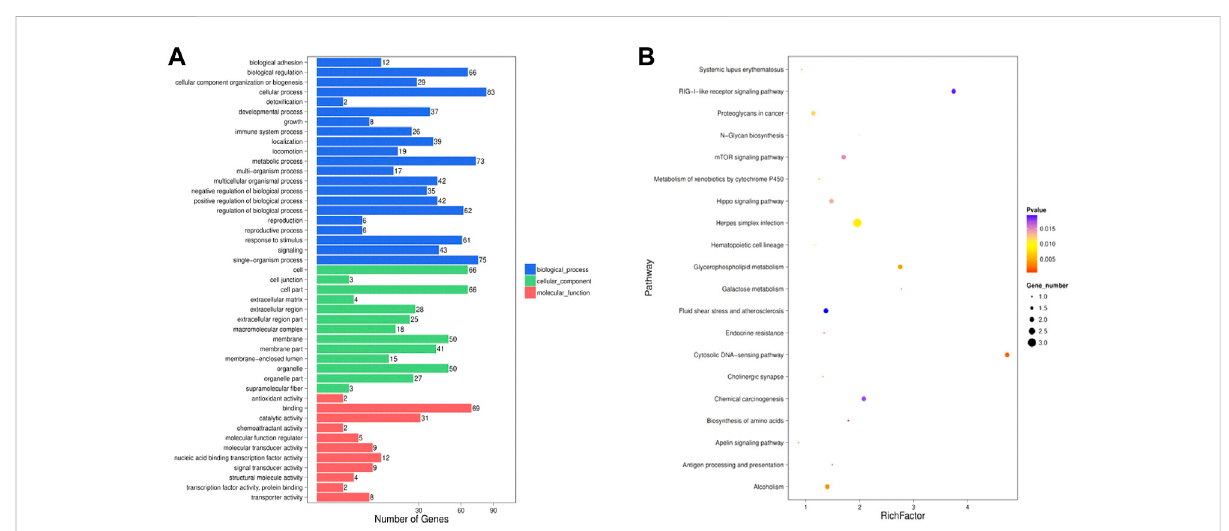
FIGURE 5 Screening of the DE lncRNAs and enrichment analysis of target genes (A) GO analysis of the DE lncRNAs were performed, imaging only those terms that were signi fi cantly enriched in the BP, CC, and MF categories. (B) KEGG analysis of the DE lncRNAs only listed the fi rst 20 signi fi cant enrichment